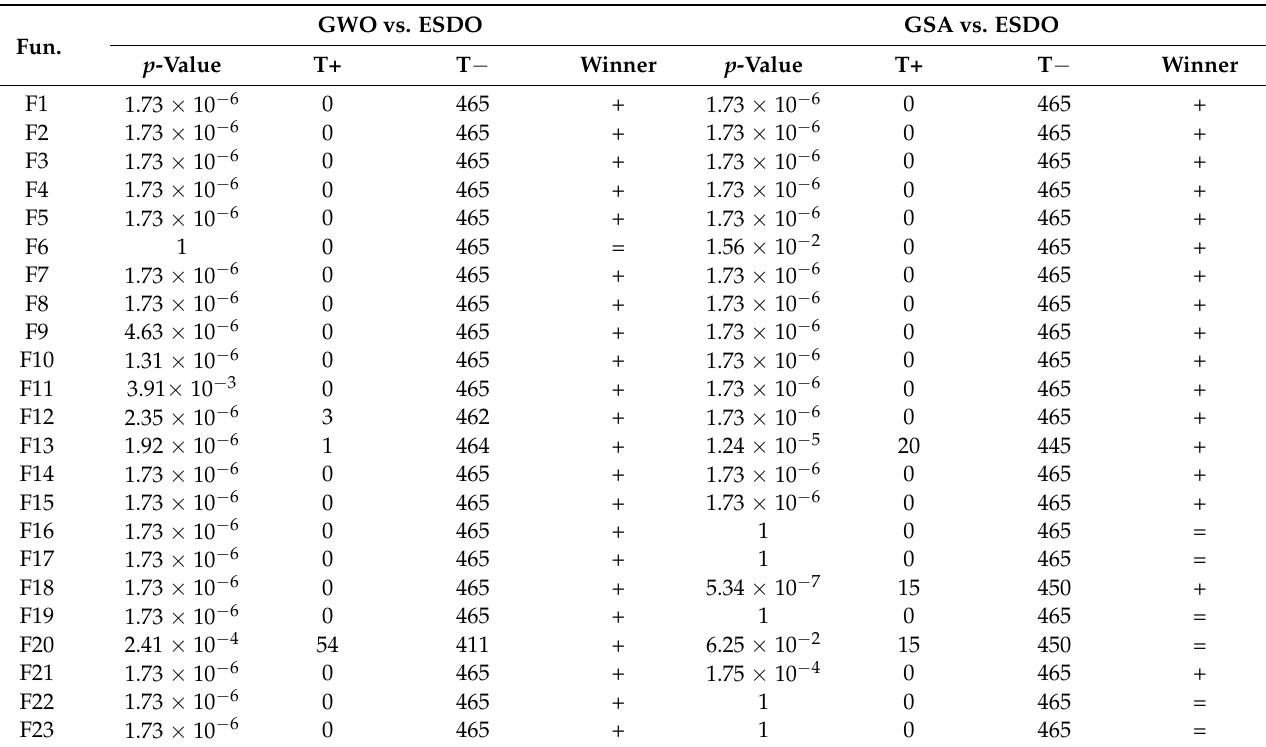
Table 6. WSRT results of ESDO for GWO and